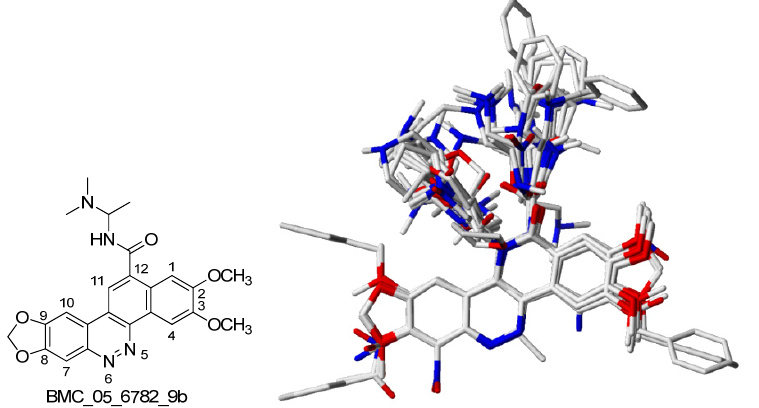
Figure 6. Structure of BMC_05_6782_9b and 3D alignment of 137 BCPs chemical